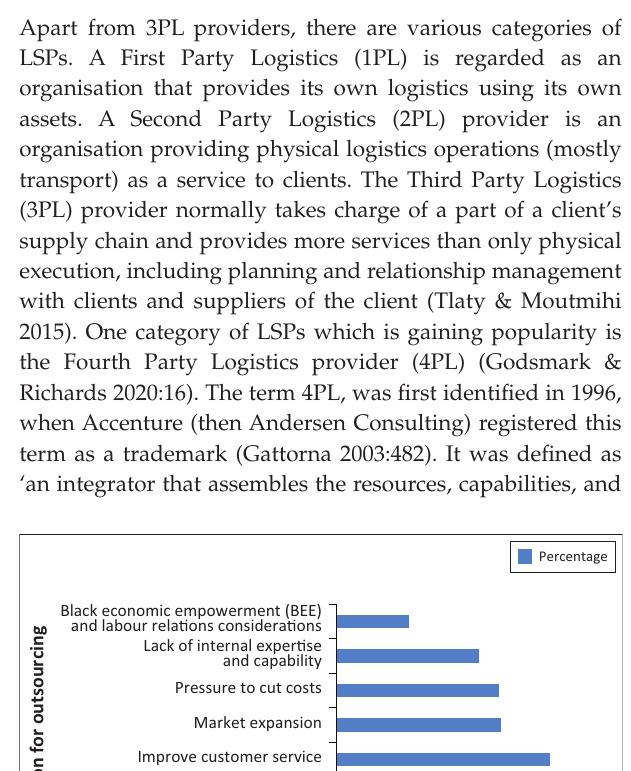
10 20 30 40 50 60 70